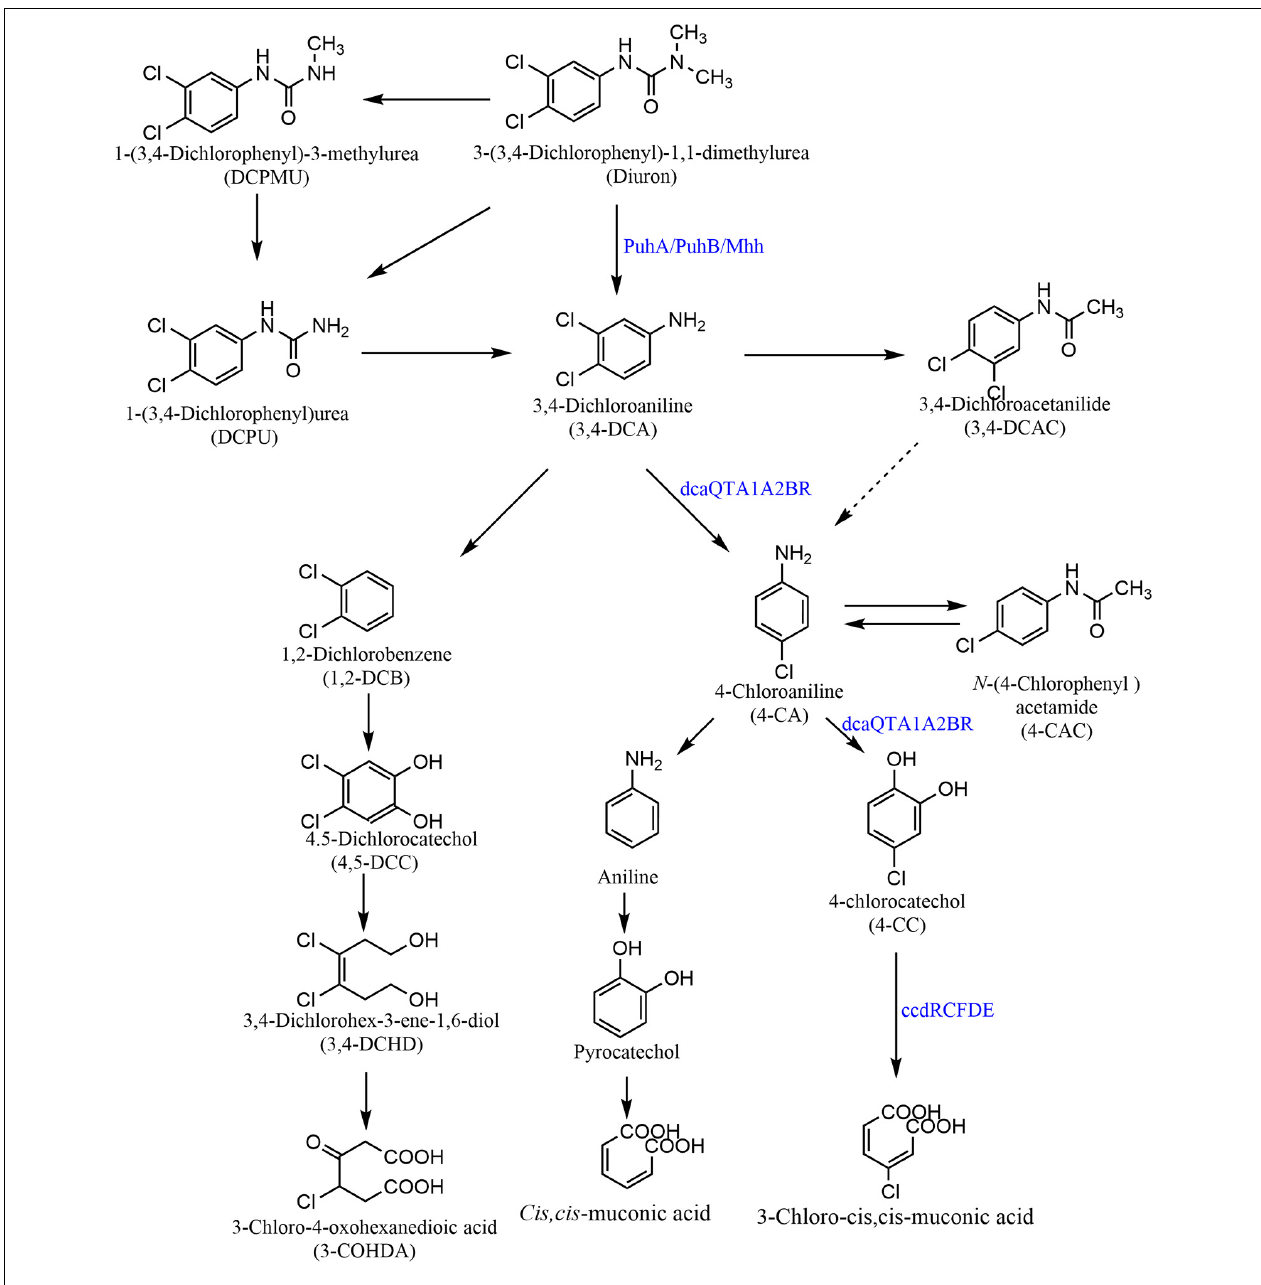
FIGURE 3 | Microbial degradation pathways of diuron. Reported diuron hydrolases convert diuron to 3,4-DCA, including PuhA, PuhB, and Mhh (Khurana et al., 2009; Zhang et al., 2018). A multicomponent dioxygenase complex encoded by dcaQTA1A2BR further mineralizes 3,4-DCA to 4-chlorocatechol. Metabolite 4-chlorocatechol is further degraded through a modified ortho-cleavage pathway encoded by ccdRCFDE (Bers et al.,